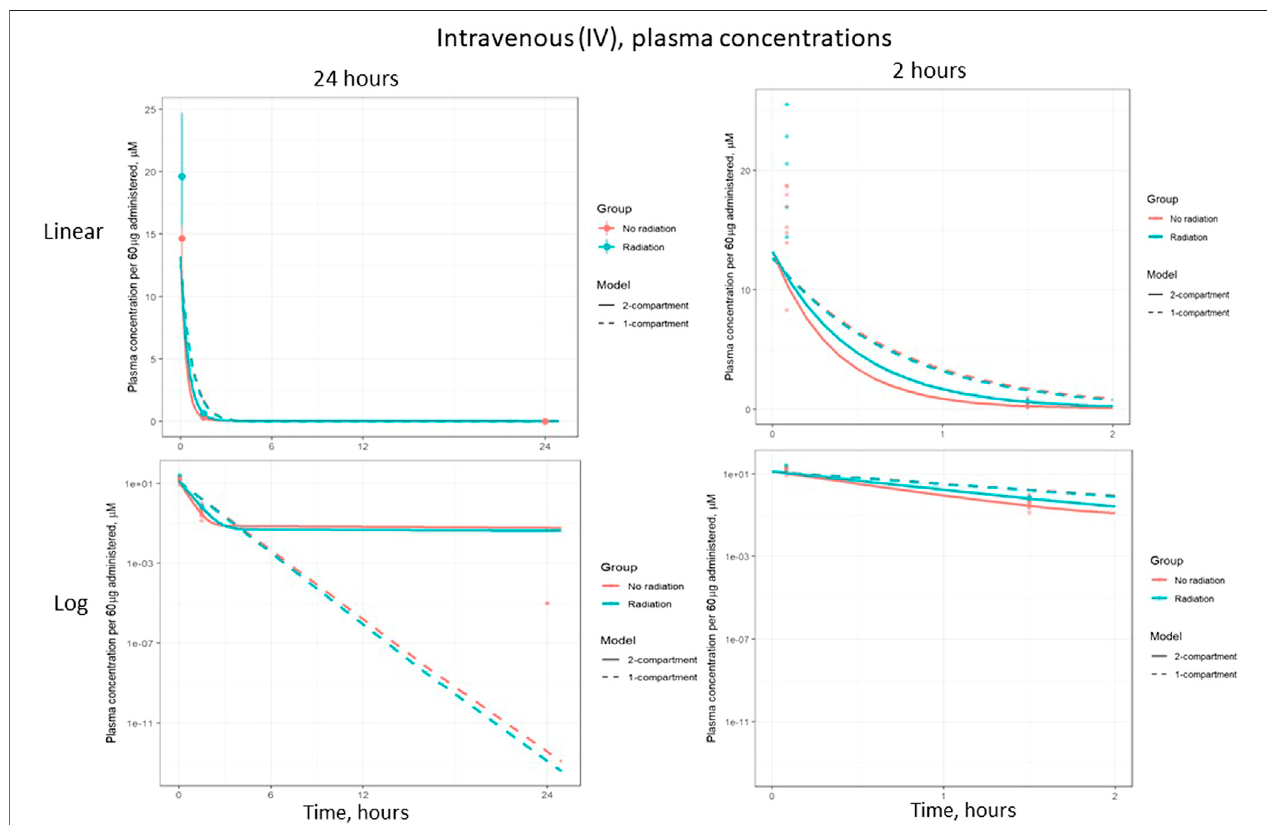
FIGURE 6 | Plasma concentration of lisinopril (geometric mean ± SD) when administered by intravenous (IV) injection, broken out by time and scale.